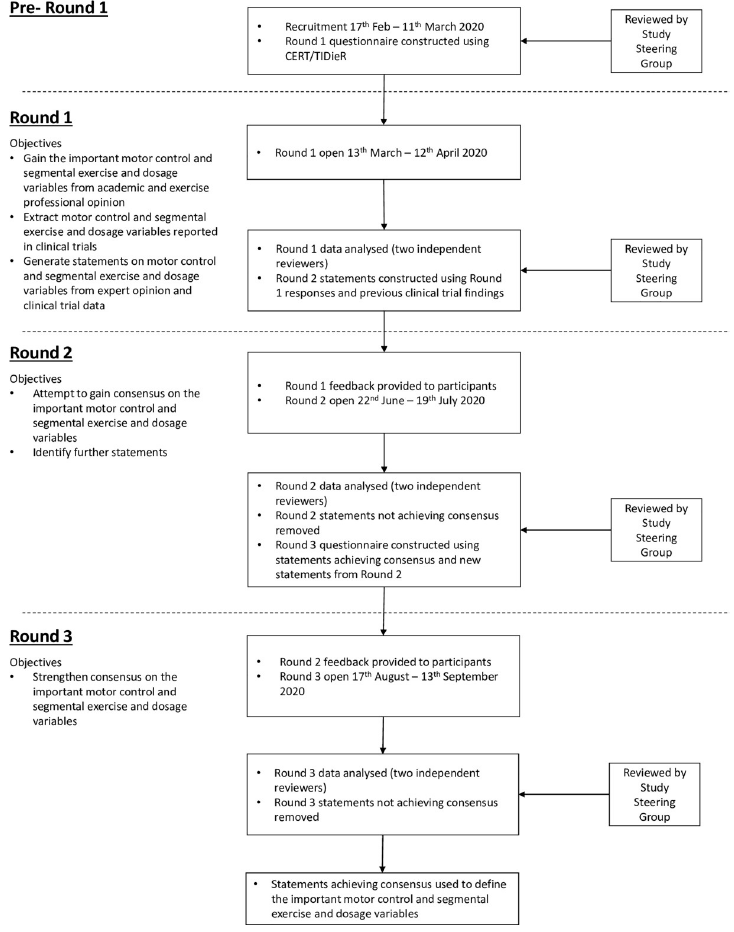
Fig 2. Study flow and